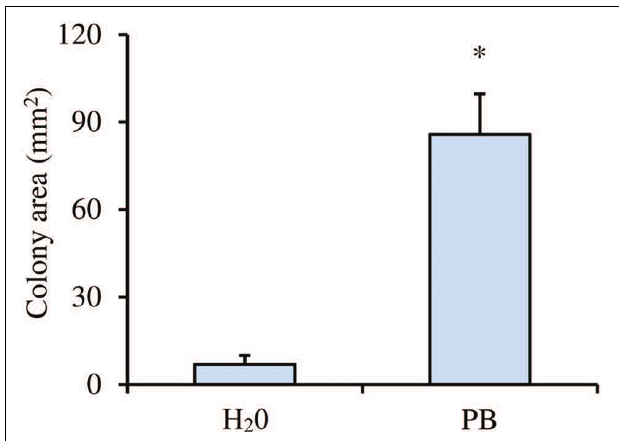
FIGURE 2 | Effect of pea broth deposited on grapevine leaves on in vitro motility of Lysobacter capsici AZ78. The bacterial colony area (mm 2 ) of L. capsici AZ78 was measured on media (0.5% Agar) coming from the leaf-washing suspension of grapevines treated with pea broth (PB) and distilled water (H 2 O). An F -test revealed non-significant differences between experiments ( P = 0.73), and data from the two experiments were pooled. Mean and standard error values were calculated as the pool of three replicates from two experiments. Asterisks indicate values that differ significantly according to Student’s t -test ( α = 0.05).